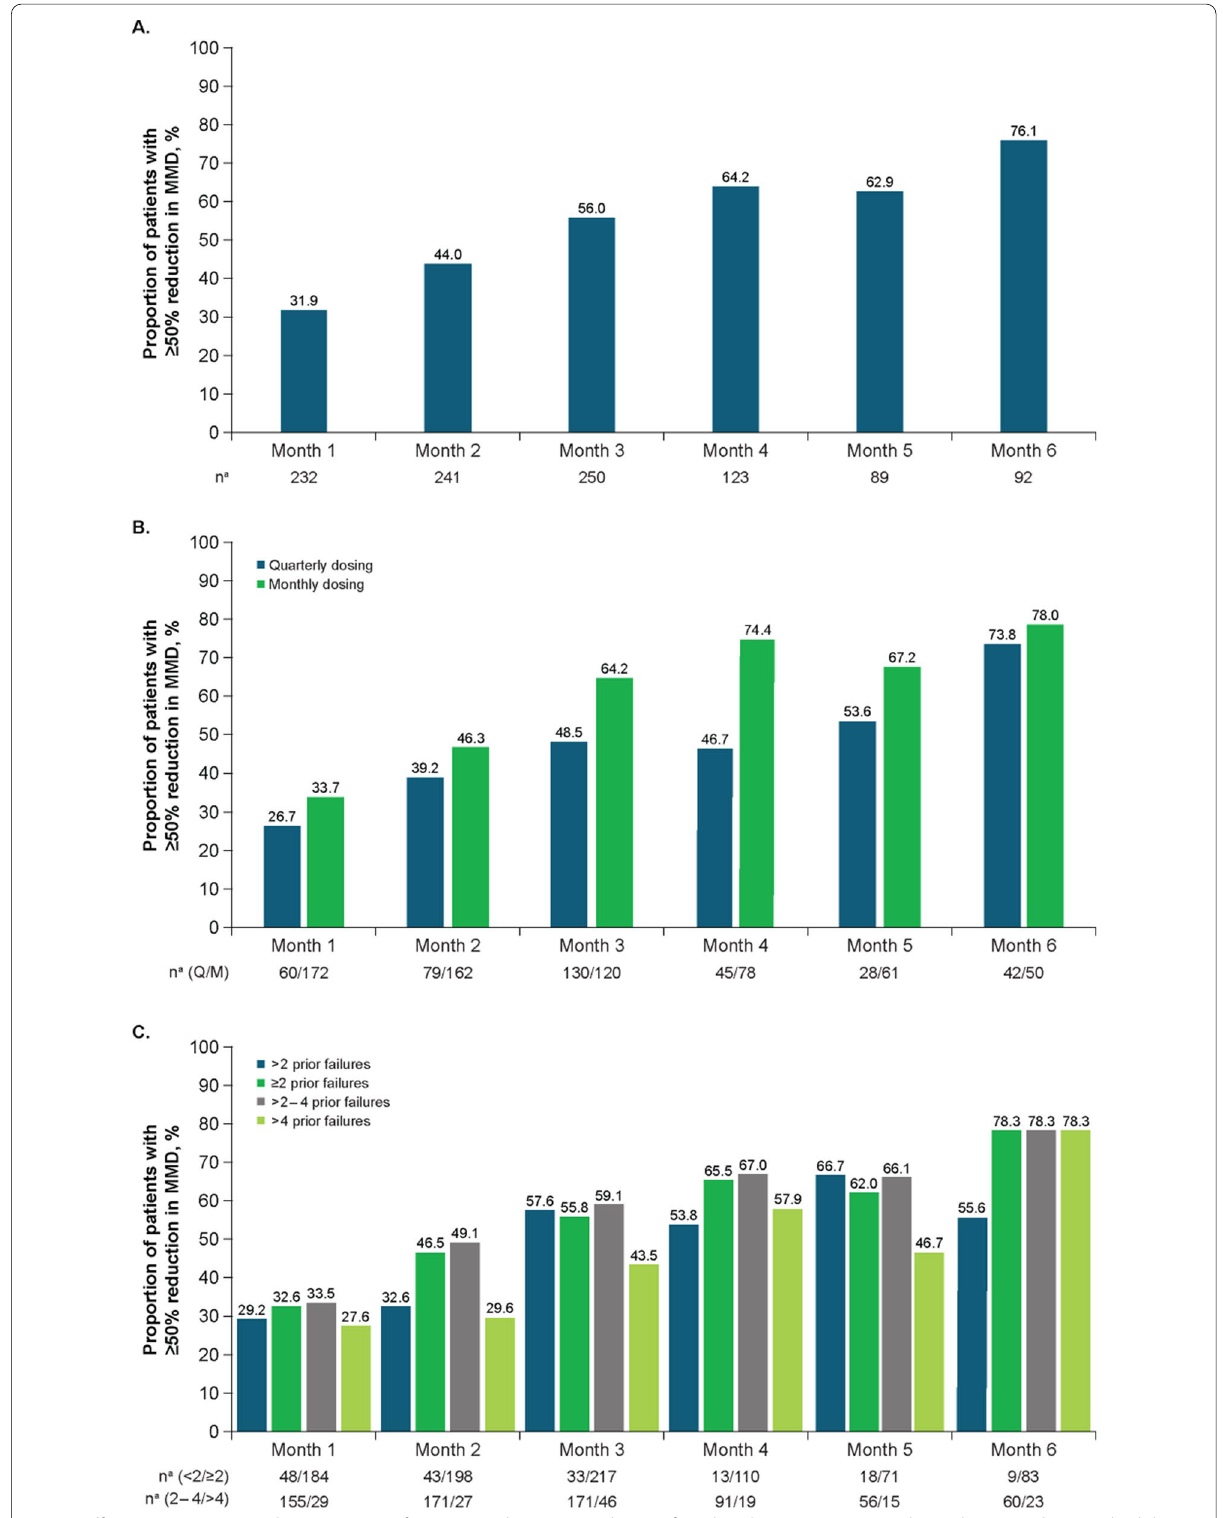
Fig. 3 Effectiveness outcomes by proportion of patients with a 50% reduction from baseline in MMD: A ) total population; B ) dosing schedule ≥ subgroups; C ) prior treatment failures subgroups. BL, baseline; MMD, monthly migraine days; Q, quarterly; M, monthly. a Number of patients with available assessment at each time